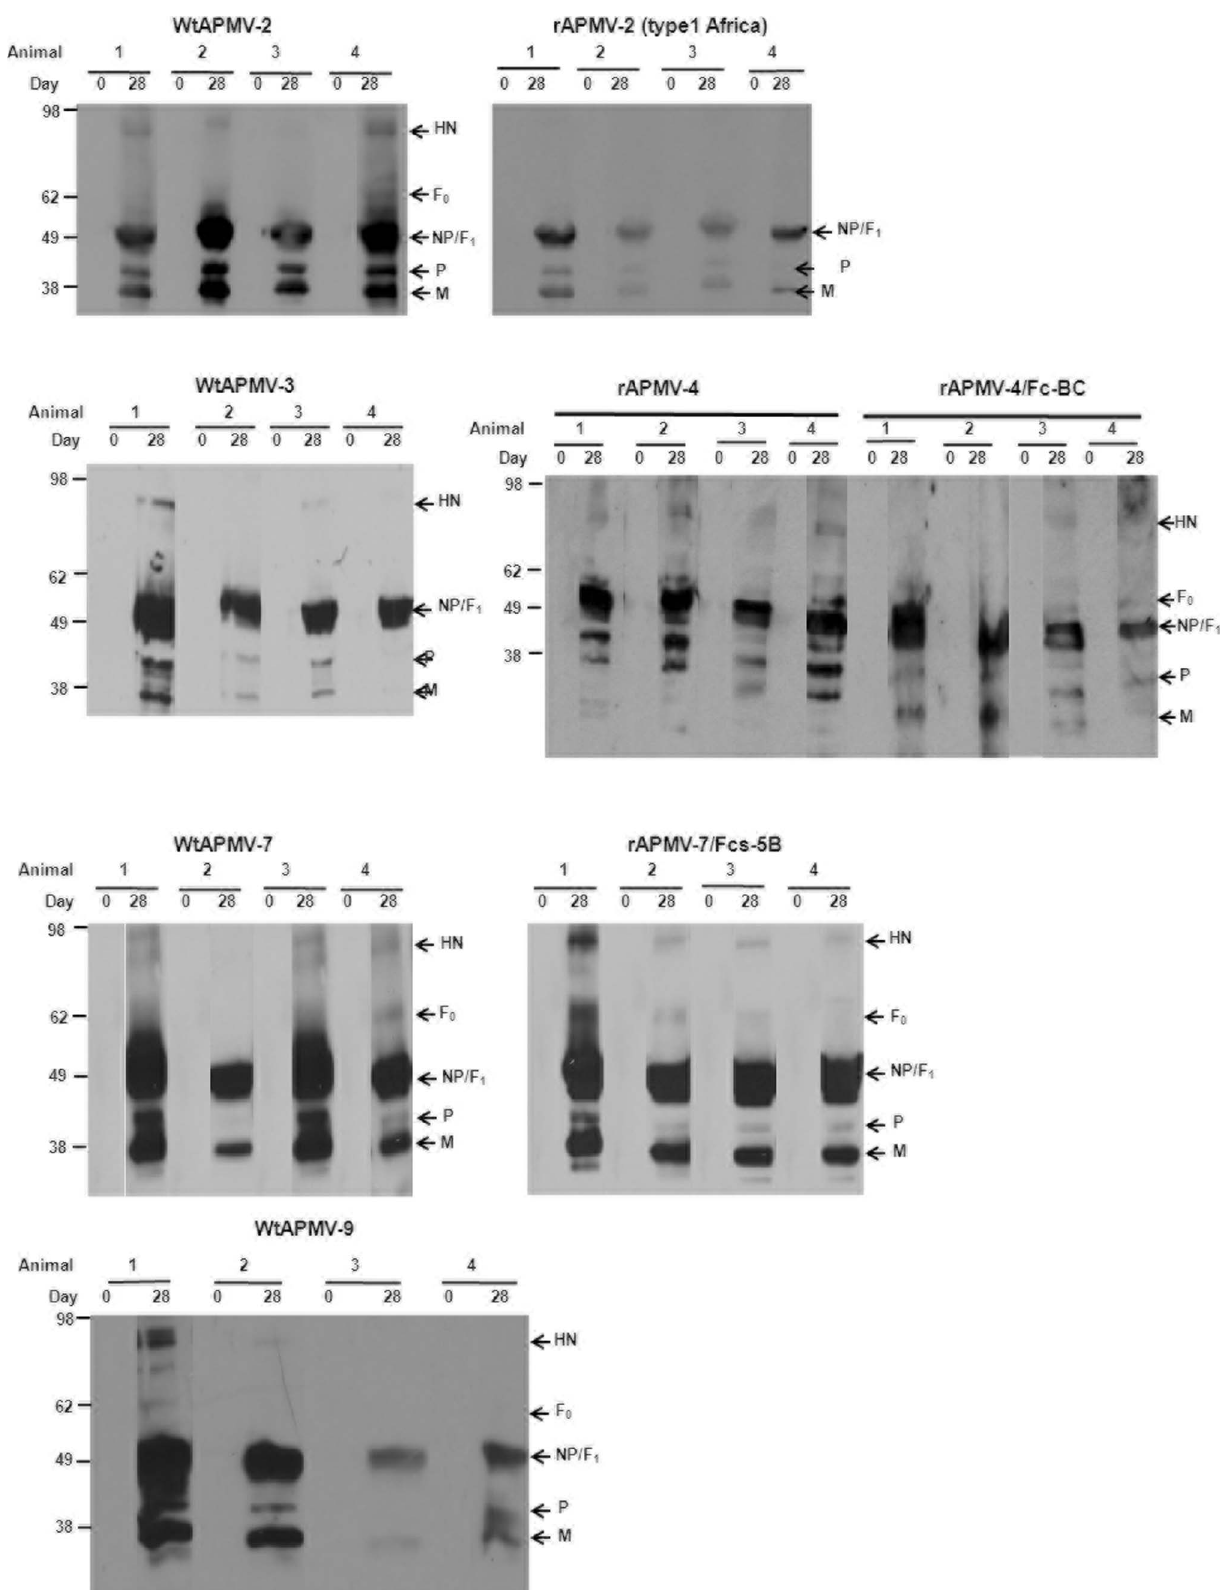
Figure 1. Analysis of the reactivity of sera from rhesus macaques collected following infection with the indicated APMVs, evaluated by Western blotting against purified virus of the homologous APMV strain. Virus representing each of the indicated APMV strains was